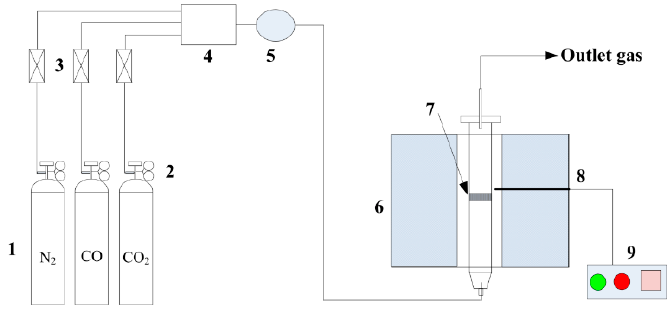
Figure 3. Schematic diagram of the experimental apparatus: 1, gas cylinder; 2, gas valve; 3, mass flow meter; 4, mixing cylinder; 5, gas drying; 6, heating furnace; 7, fluidized bed (porous quartz plate); 8, thermocouple; 9, temperature